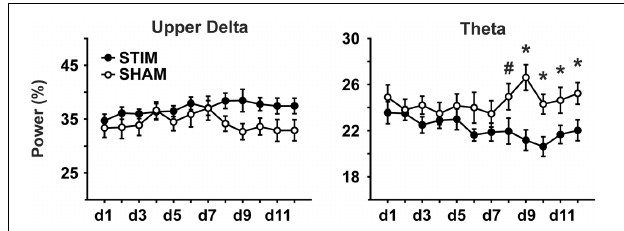
FIGURE 4 | EEG power during the acute (sham)stimulation. A significant group difference and an interaction could only be seen for the theta band (5.00–9.03Hz). Note, SO power could not be analyzed due to frequency overlap with SO-tDCS. ANOVAs for repeated measures followed by post-hoc t -tests. ∗ p < 0 . 05, # p < 0 . 01.